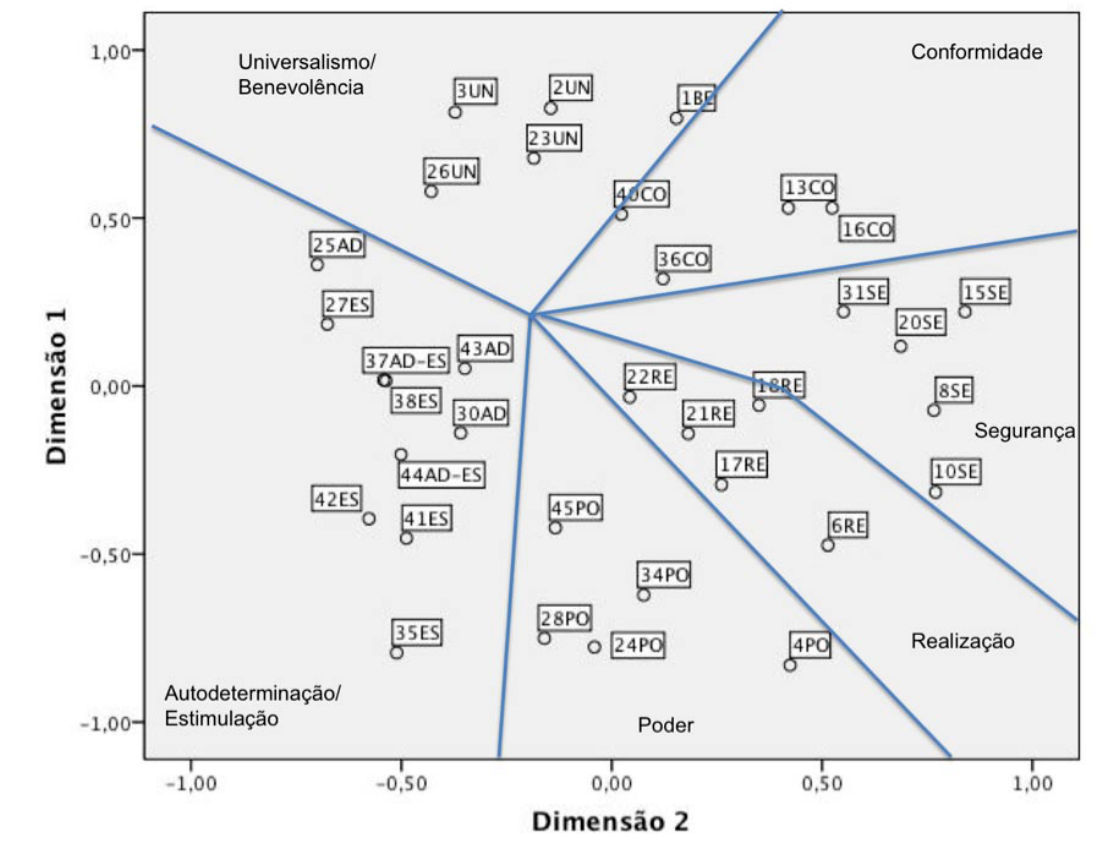
Figura 2 . Gráfico de sedimentação do escalonamento multidimensional da